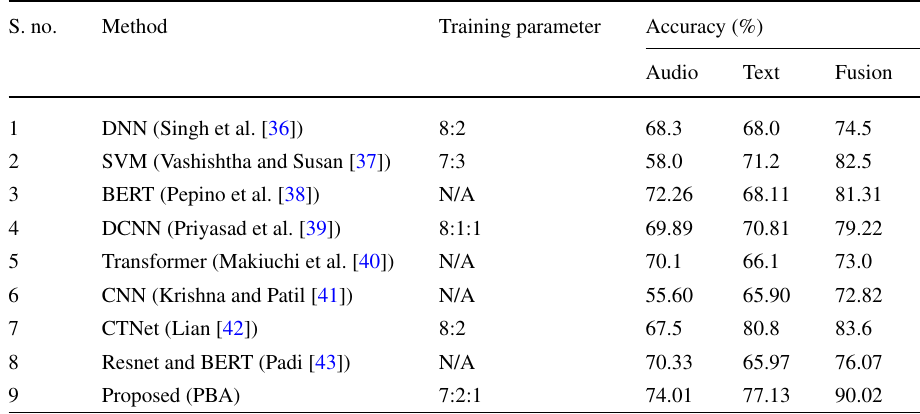
Table 6 Accuracy comparison with other papers S.